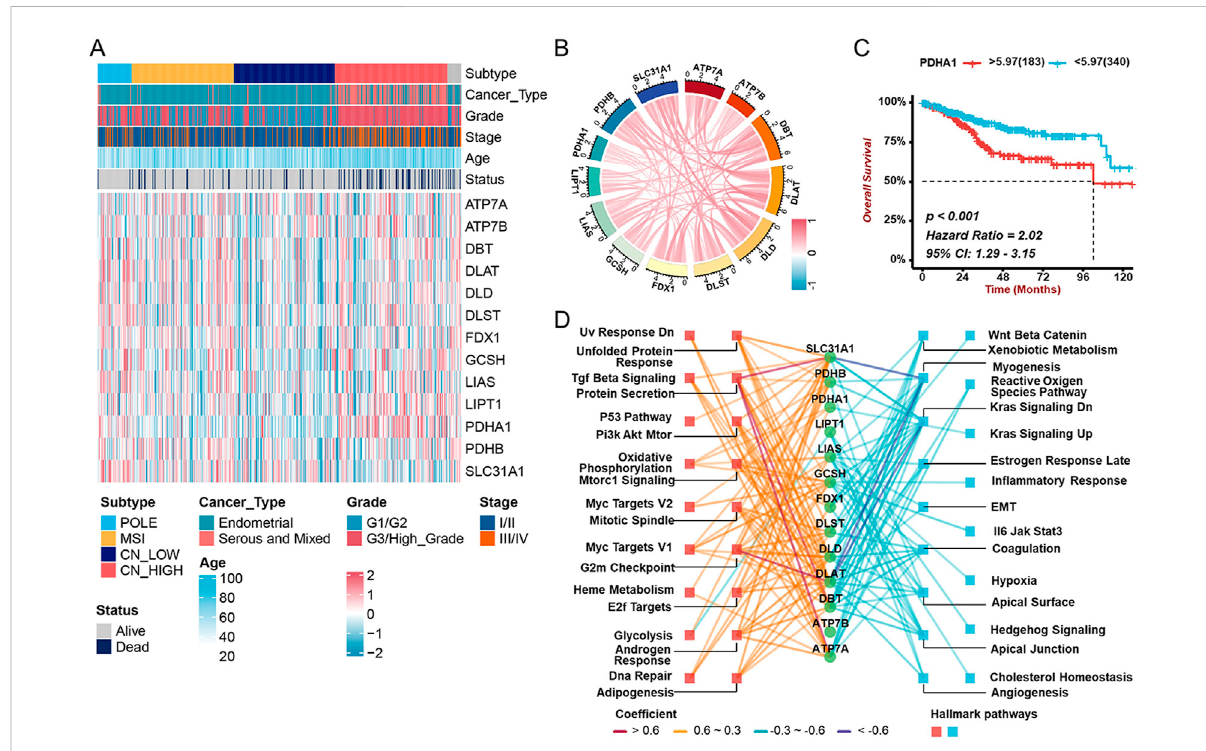
FIGURE 2 Associations between cuproptosis gene expression and clinicopathological characters and prognostic (A) The heatmap revealing the correlations between clinicopathological characters and 13 cuproptosis genes ’ expression in TCGA-UCEC cohort. (B) The correlation among the mRNA levels of cuproptosis genes in TCGA-UCEC cohort. (C) The Kaplan-Meier analysis demonstrating the prognostic signi fi cance of PDHA1 in TCGA-UCEC cohort. (D) The correlation between cuproptosis genes and cancer hallmark pathways. The colors represent different